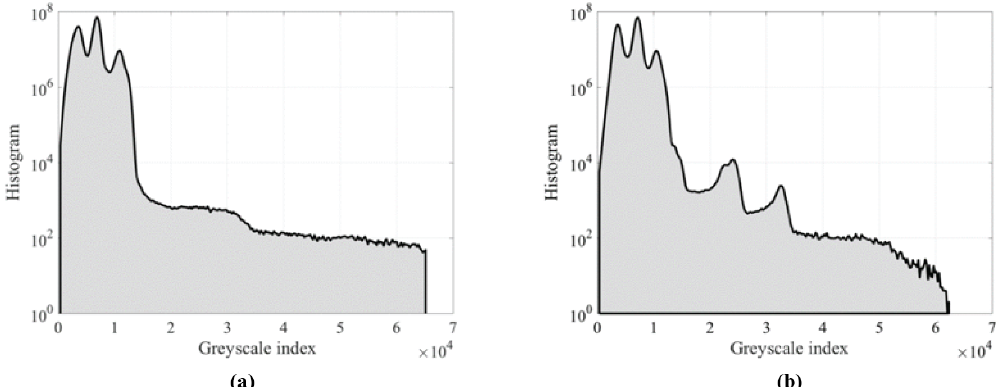
Figure 5. Histogram of (a) Scarborough and (b) Cottesloe Beach sand samples.